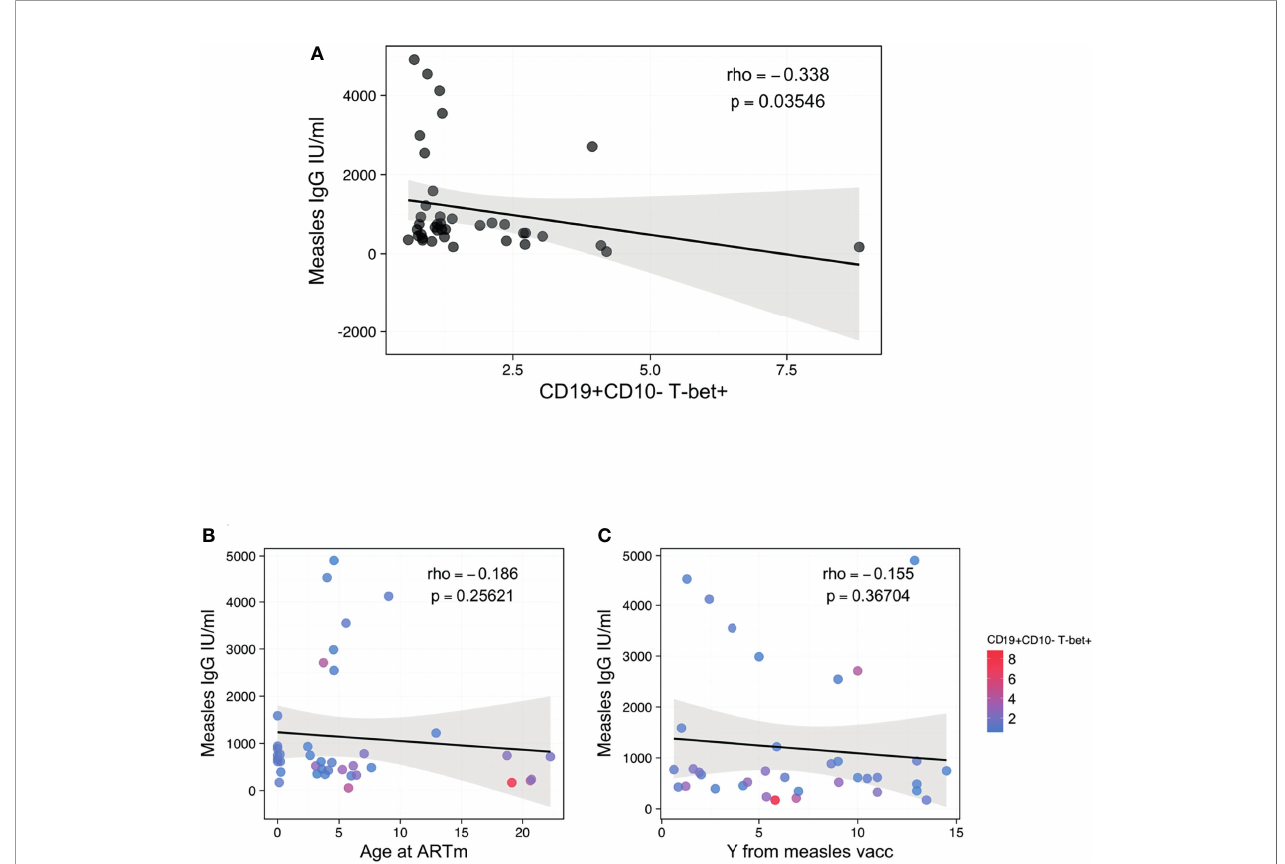
FIGURE 4 | Association between ABCs and anti-measles humoral response. (A) Spearman correlation between CD19+CD10- B-cells T-bet+ and anti-Measle plasma IgG titers, with rho and p de fi ning the statistical signi fi cance. (B, C) Spearman correlation between anti-Measle plasma IgG titers and Age at ART in m and years from measles vaccination, respectively, with rho and p de fi ning the statistical signi fi cance. Color dots show the distribution of CD19+CD10- B-cells T-bet+. Signi fi cance was set at